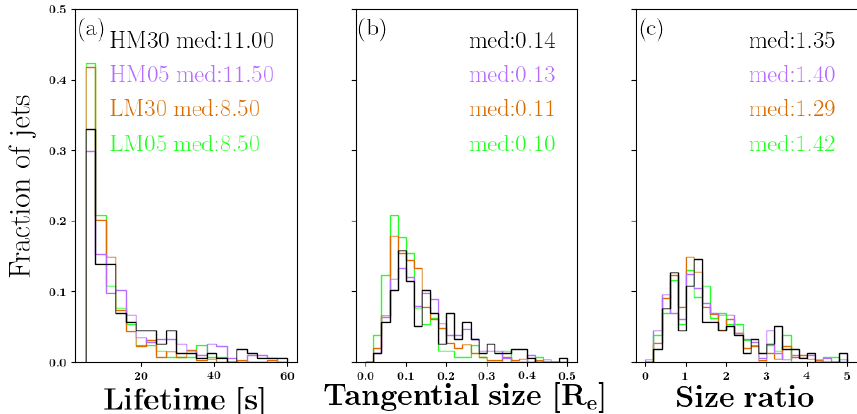
Figure 7. Histograms of Vlasiator jets illustrating (a) the jet lifetime, (b) the jet tangential size, and (c) the jet size ratio, defined as the radial size divided by the tangential size. The colours refer to the different runs, with the run identifier (see Table 1): orange and green (black and purple) are the low (high) M A runs, respectively.